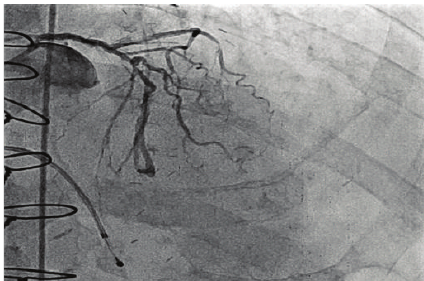
Figure 8: LIMA to LAD graft with retrograde blood flow